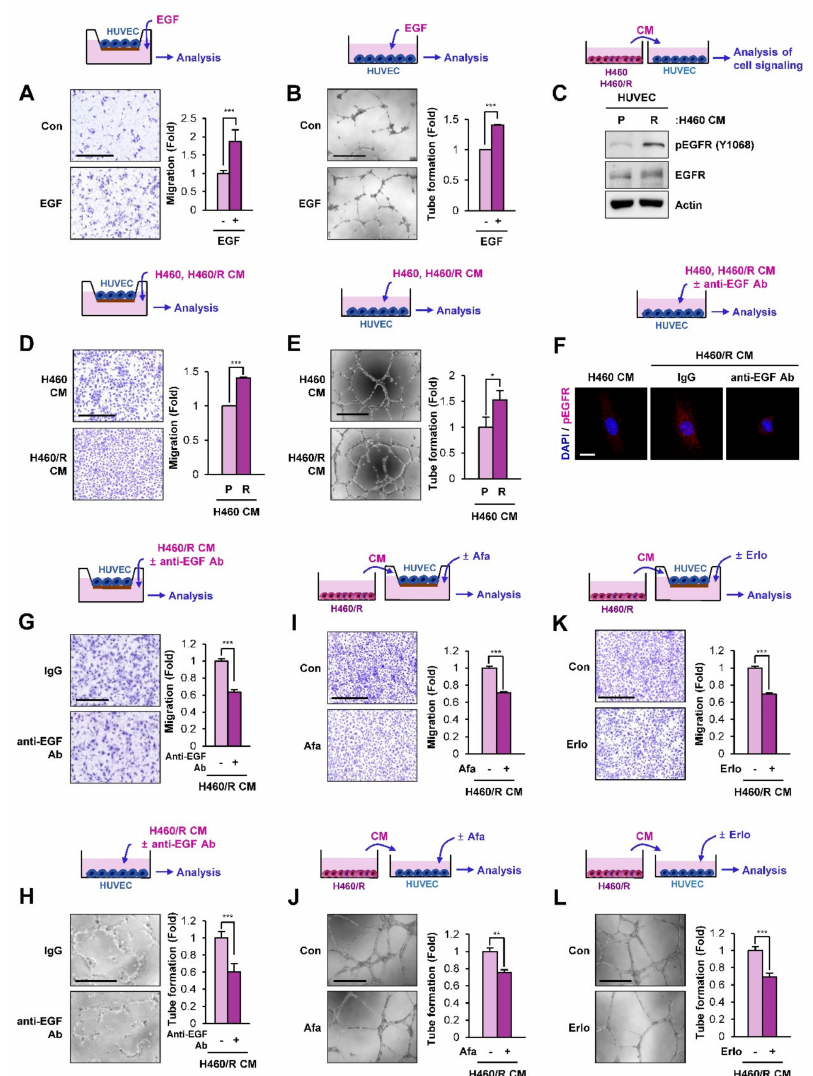
Figure 5. Association of EGF with proangiogenic behavioral changes in human umbilical vein endothelial cells (HUVECs) mediated by communication between H460 / R cells and HUVECs. ( A, B ) The increased migration ( A ) and tube formation ( B ) of HUVECs treated with EGF (50 ng / mL) were determined by migration and tube formation assays, respectively. Scale bar: 500 µ m. ( C) The activation of EGFR in HUVECs treated with conditioned medium (CM) derived from H460 / R cells compared with those treated with CM derived from H460 cells was determined by a Western blot analysis. ( D, E ) The increased migration (D ) and tube formation ( E ) of HUVECs treated with CM derived from H460 / R cells by comparison with those treated with CM derived from H460 cells were determined by migration and tube formation assays, respectively. Scale bar: 500 µ m. ( F–H ) Inhibition of H460 / R CM-induced EGFR phosphorylation (F ), migration ( G ), and tube formation ( H ) by co-incubation with an anti-EGF neutralizing antibody (1 µ g / mL) in HUVECs. Scale bars: 20 µ m ( F ), 500 µ m ( G, H) ( I, K ) Blockade of the H460 / R CM-induced migration of HUVECs by treatment with afatinib (Afa; 20 nM) ( I ) and erlotinib (Erlo; 5 µ M) ( K ). Scale bar: 500 µ m. ( J, L ) Inhibition of H460 / R CM-induced tube formation in HUVECs by treatment with afatinib (Afa; 20 nM) ( J ) and erlotinib (Erlo; 5 µ M) ( L ). Scale bar: 500 µ m. For all panels, the bars represent the mean ± SD. * p < 0.05, ** p < 0.01, and *** p < 0.001, as determined by two-tailed Student’s t